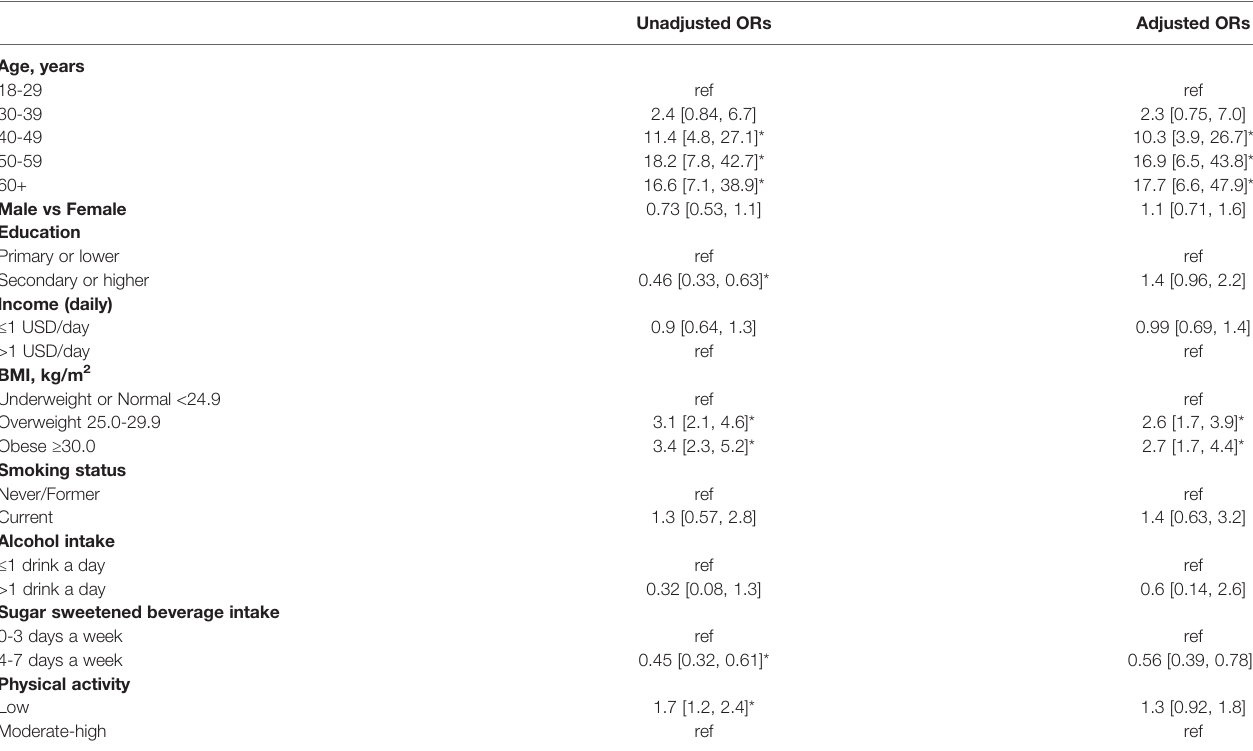
TABLE 3 | Factors associated with diabetes among adults in Haiti, multivariable logistic